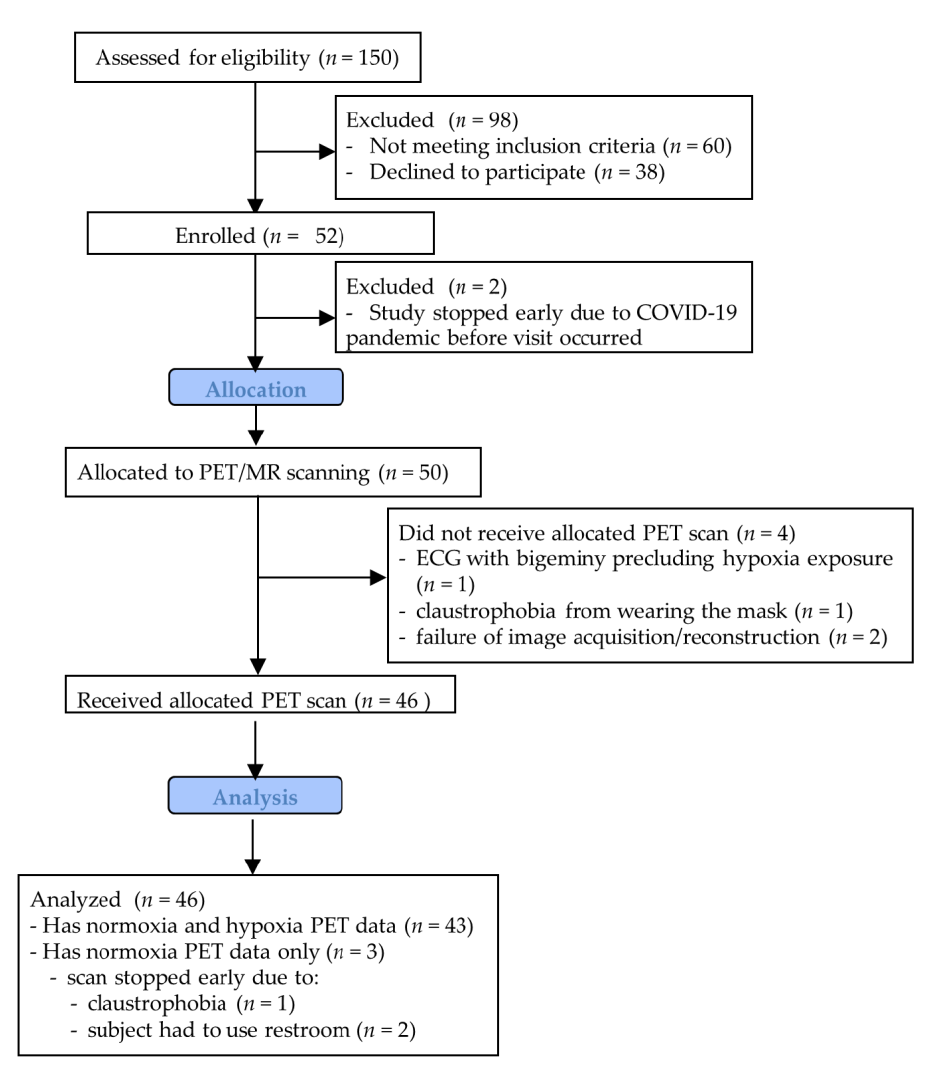
Figure 3. Schematic showing participant flow through the study. Table 2. Cardiac MRI measurements and vital signs.